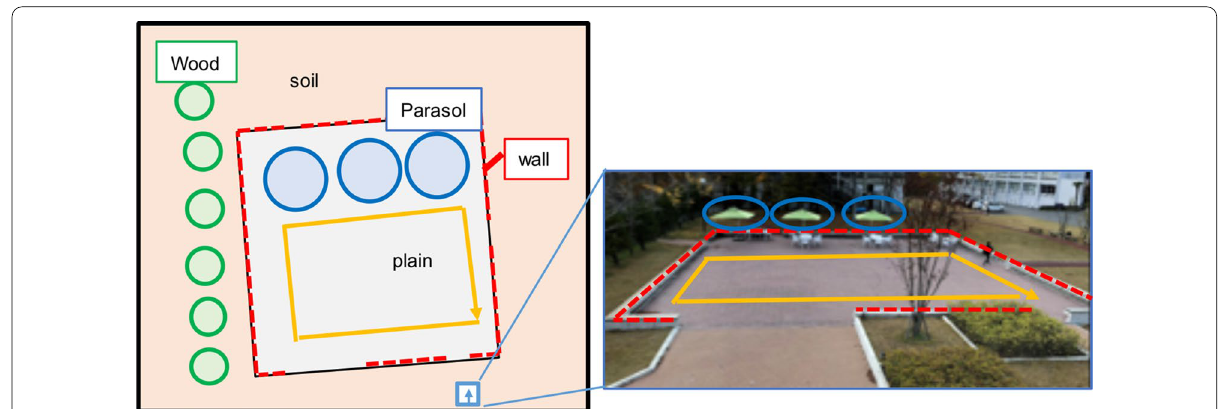
Fig. 9 Experimental environment (square)